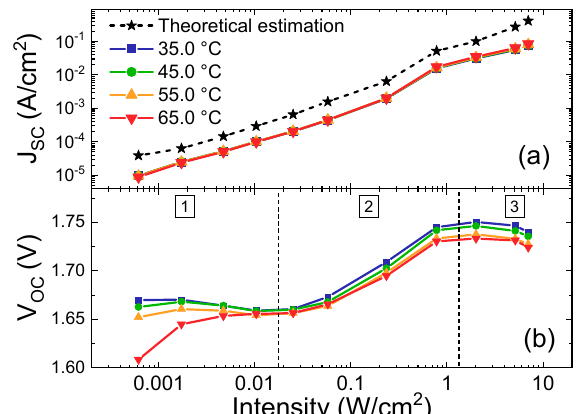
Figure 3. I–V behavior at different excitation densities, with the device at 35.0 °C ( a ) and series resistance calculated from illuminated I–V ( b ).